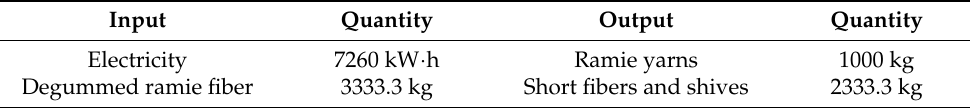
Table 4. Inputs and outputs of producing 1000 kg ramie yarns.